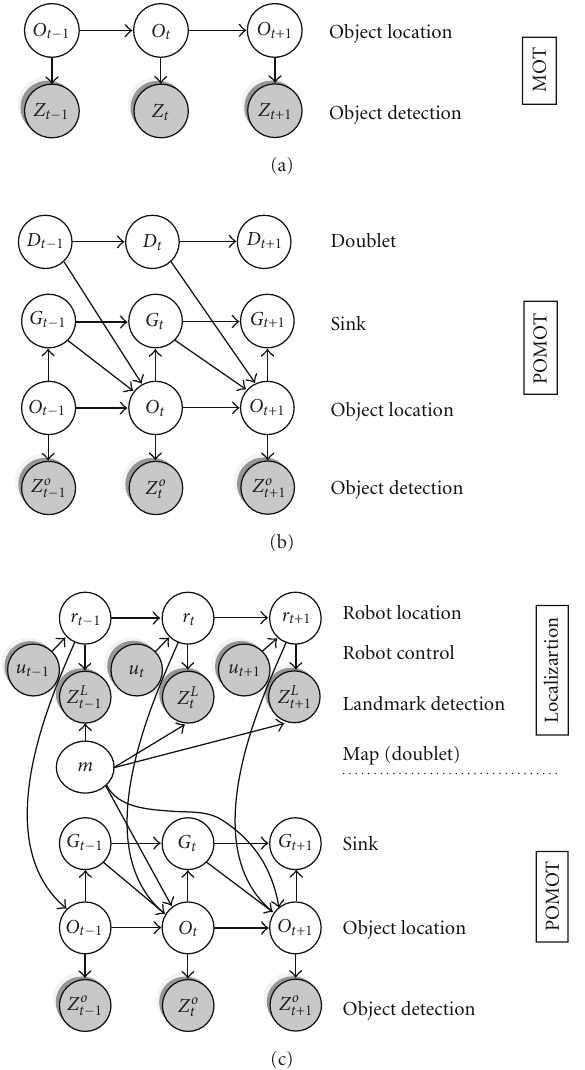
Figure 4: Dynamic Bayesian Networks (DBNs) of (a) traditional tracking, (b) stream field-based tracking, and (c) localization and